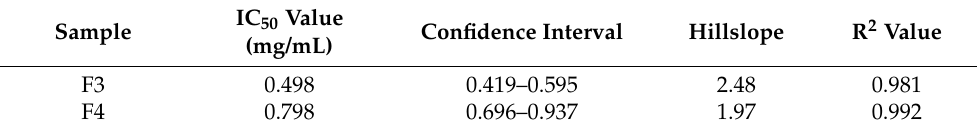
Figure 7. Concentration–inhibition response curves for F3 and F4 fractions from D. vermicularis used for the calculation of their antioxidant activity by using the reduction in the radical cation (ABTS assay). Table 4. Dose–inhibition results for D. vermicularis nonpolar fractions using ABTS in vitro assay ( n = 4) to obtain the half-maximal inhibitory concentration (IC 50 ) with presented confidence intervals, Hillslope, and R 2